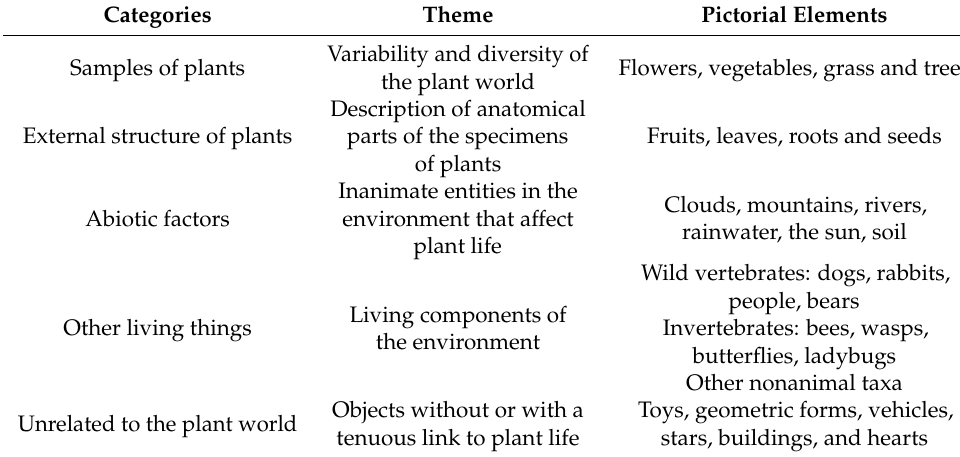
Table 1. A description of the pictorial categories considered in the study, as well as some examples of images found in the